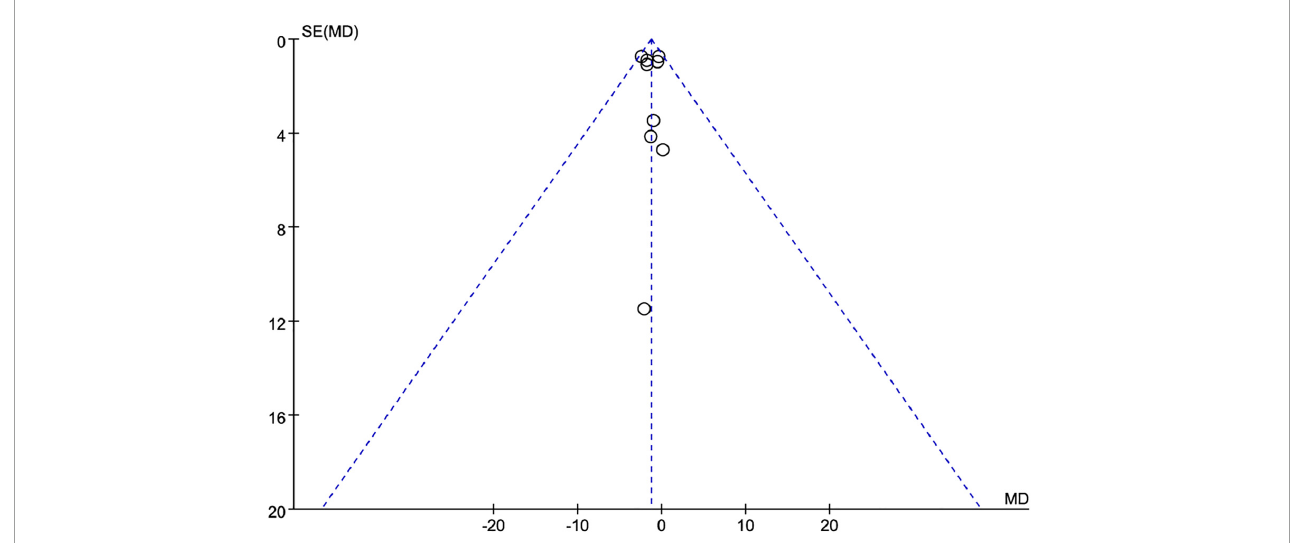
FIGURE2 Funnel plot for publication bias detection on weight loss changes. MD, mean difference; SE, standard